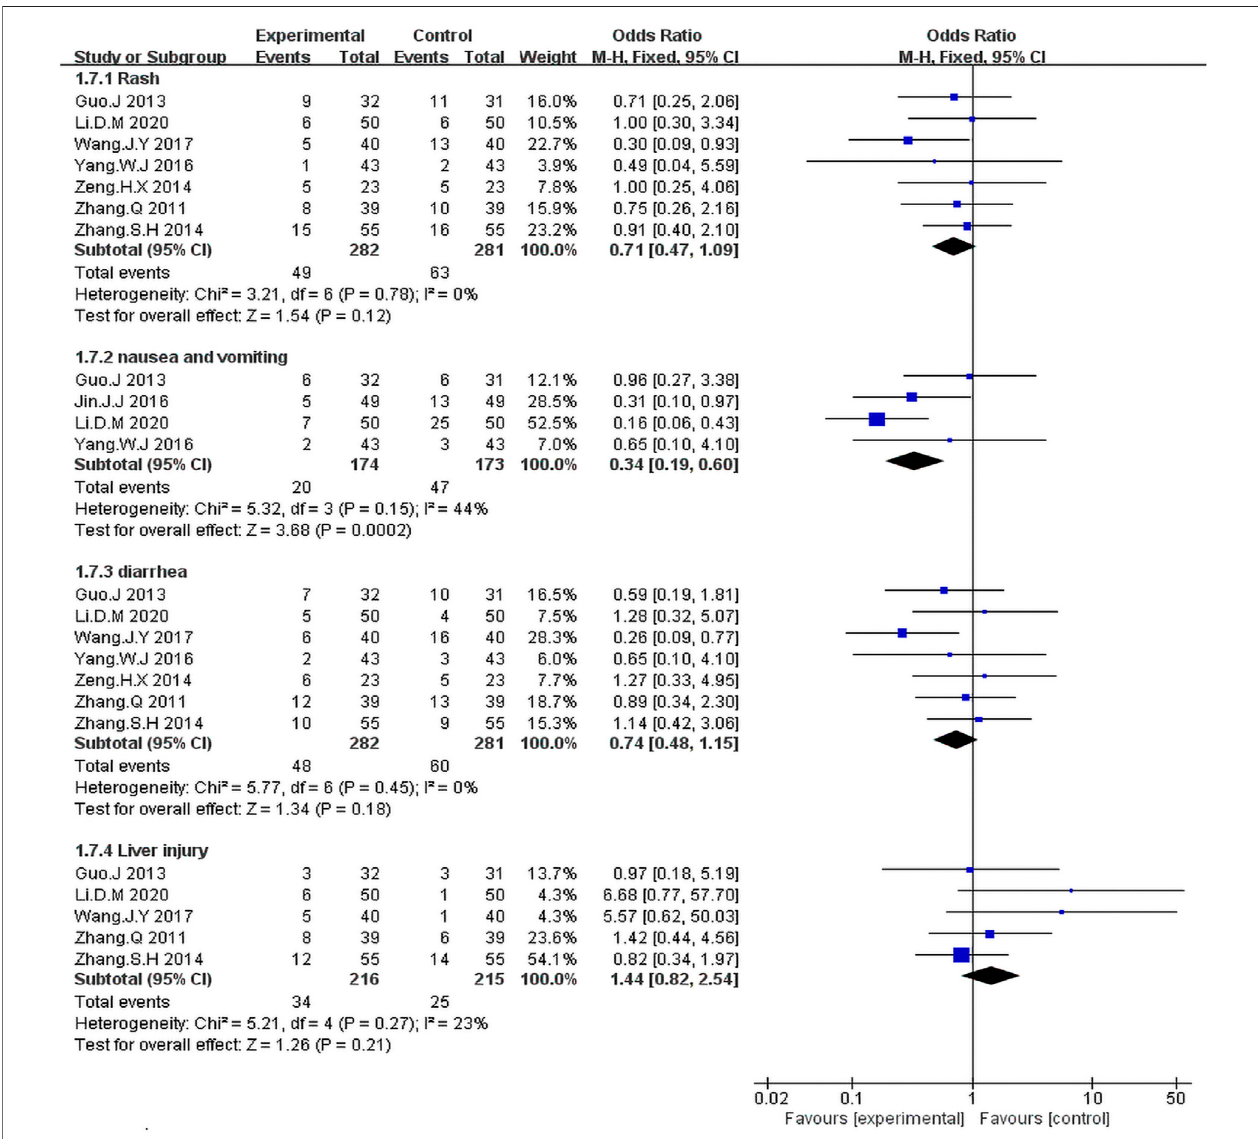
FIGURE 8 | Forest plot of adverse events in the patients treated with EGFR-TKI + KLT and EGFR-TKI alone.